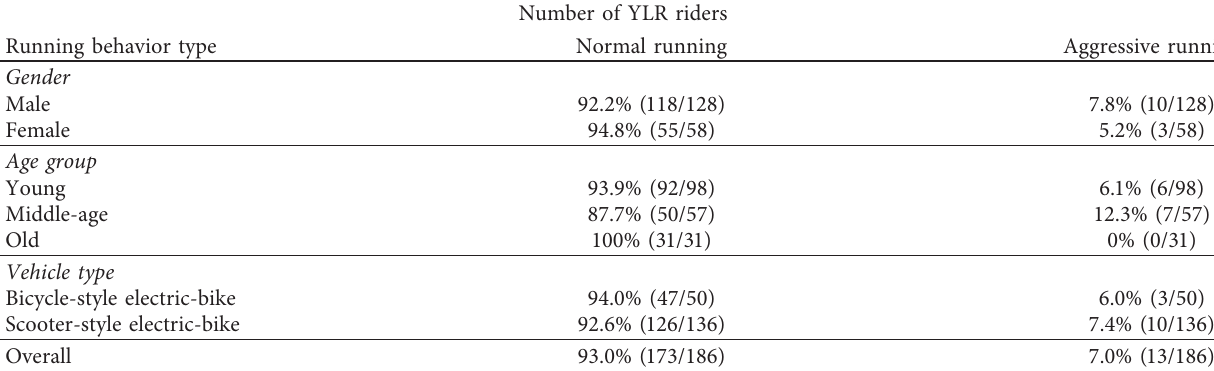
Table 2: Statistics of yellow-light running behaviour by each